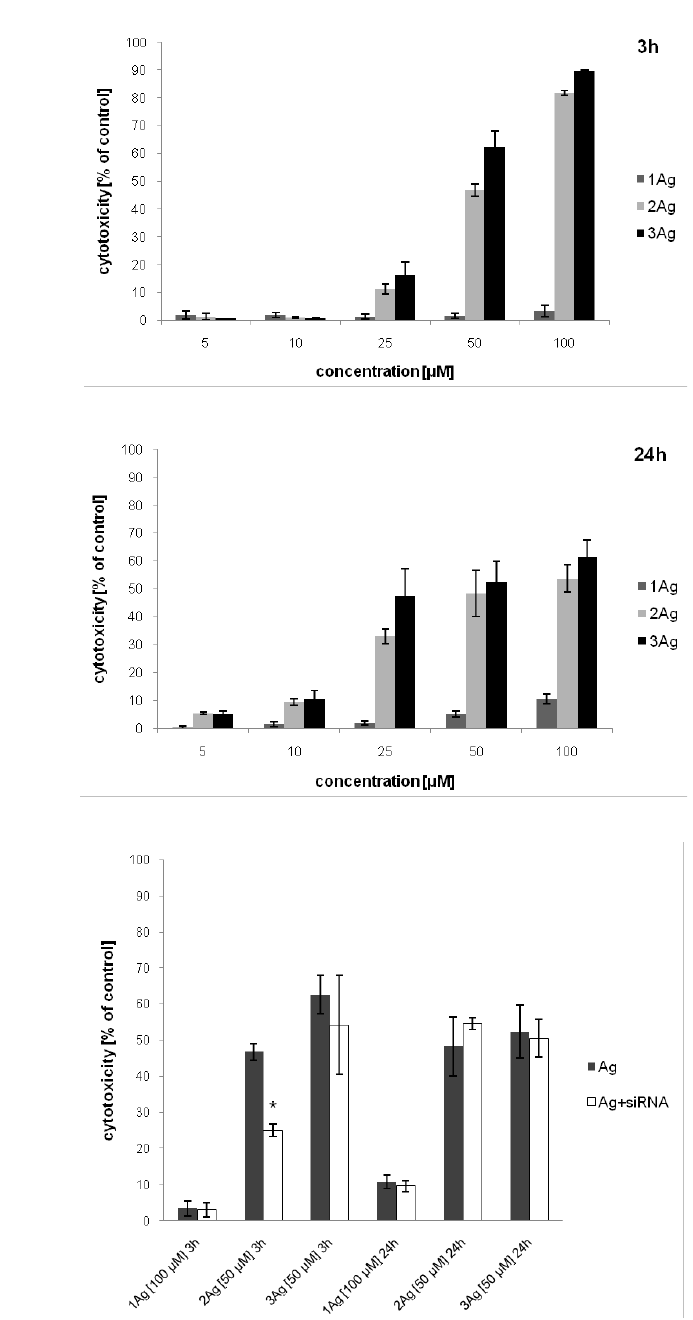
Figure 10. Cytotoxic e ff ect of AgNPs ( A , B ) and their complexes with siRNA (siBcl-xl) ( C ) on HeLa cells. Viability was determined by the LDH assay after 3 and 24 h of treatment. The abscissa values refer to the dendron concentration. Data presented as the percentage of cytotoxicity compared to control (untreated) cells, mean ± SD, n = 3. * Statistically significant di ff erence compared to free nanoparticle at p <